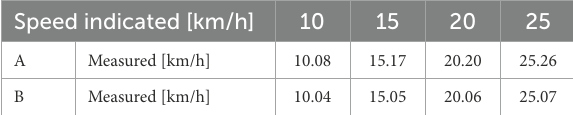
TABLE 1 Different conditions at which the drag test was performed. Condition